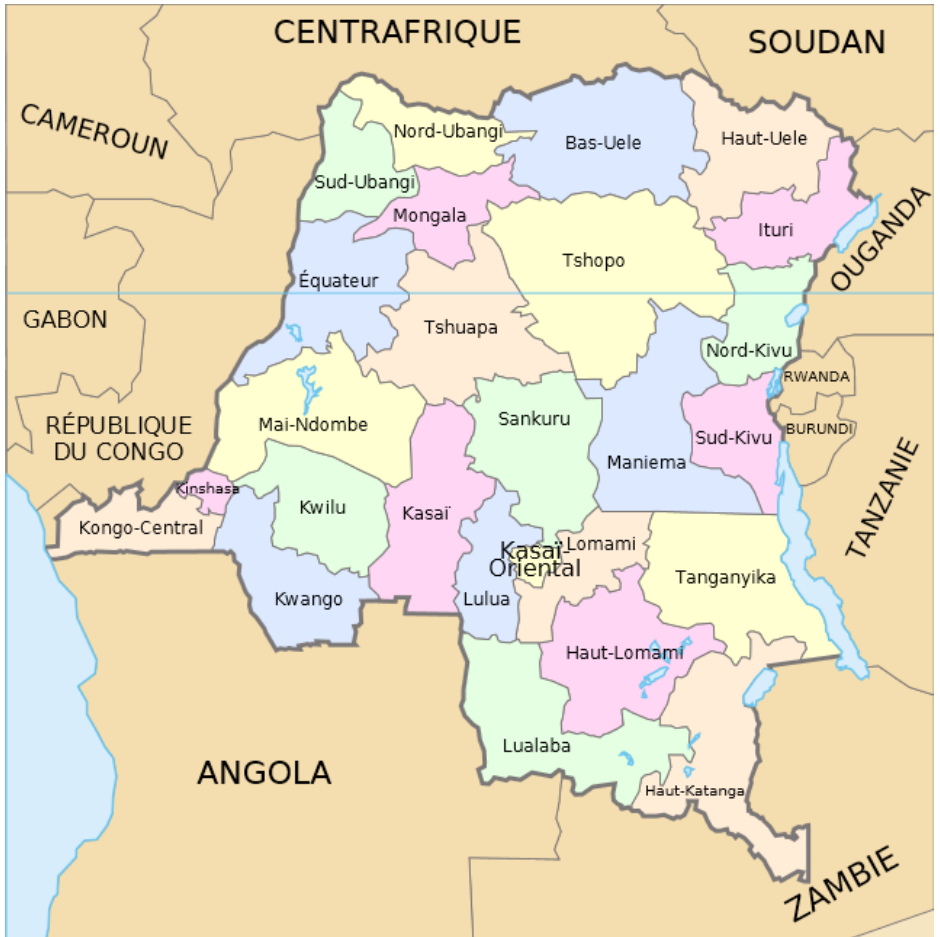
Figure 0A: A map showing the study country and South-Kivu Province among the 26 Provinces of DRCongo